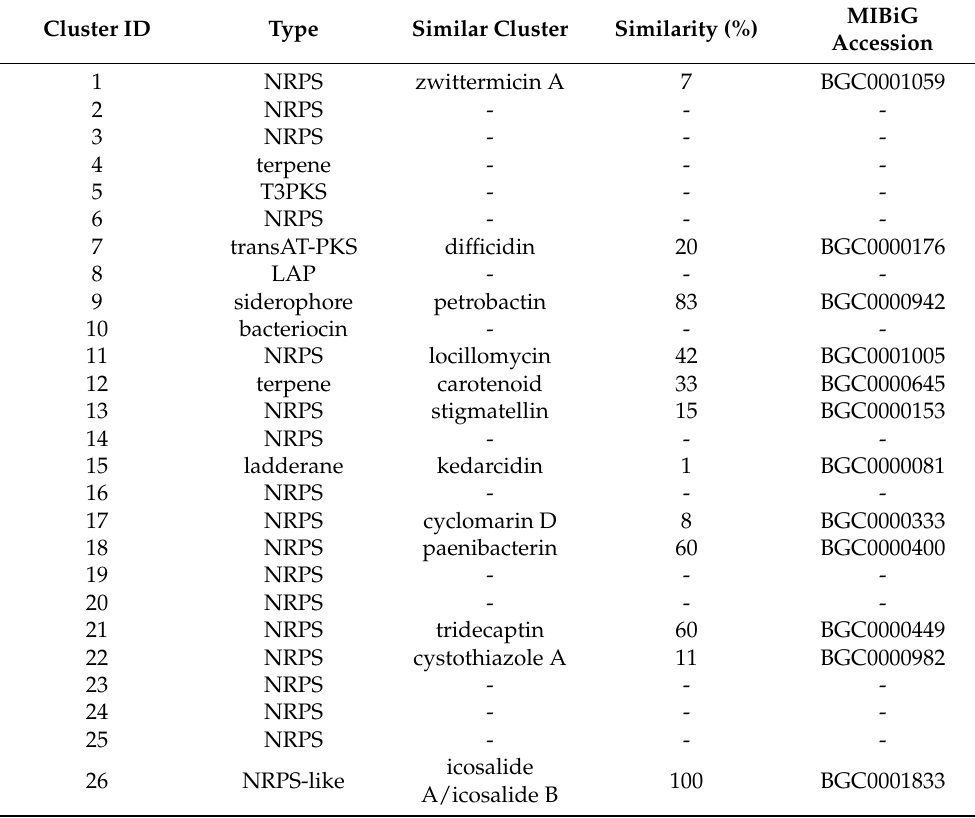
Table 3. The putative gene cluster encoding secondary metabolites in P. mucilaginosus G78.